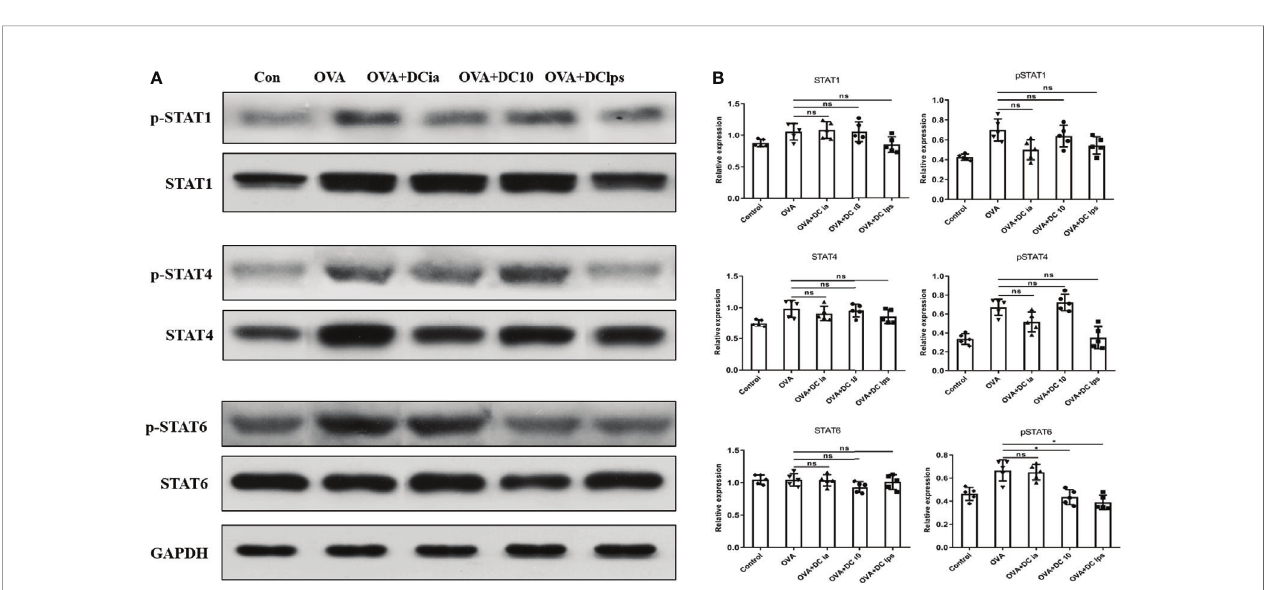
FIGURE 8 | Adoptive transfer of DClps decreased the phosphorylation level of STAT6 in OVA-induced asthmatic mice. (A) Expression and phosphorylation of STAT determined by WB. (B) Quanti fi cation of STAT expression and phosphorylation, normalized to GAPDH, shown as relative expression. The columns and error bars represent the mean and SEM. (*P < 0.05, ns, no signi fi cant difference, ANOVA with Tukey ’ s post hoc analysis). The same experiment was repeated three times with similar results (n = 5 in each